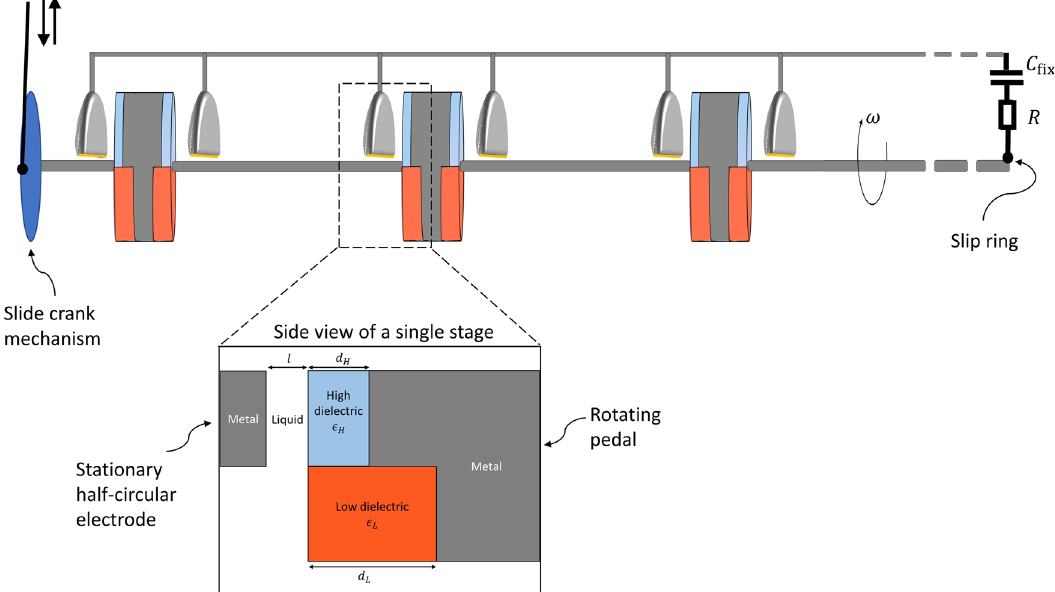
Fig. 2 Illustration of the energy harvesting device. The device comprises of a multi-stage rotor structure, connected to a reservoir capacitor C fix and to an electric load R . The design of the rotor structure is presented (not to scale) with an additional side view of a single stage which consists of a rotating disc and a stationary half-circular metal electrode; in the gap between the two is a lubricating liquid. Each rotating disc is shared by two adjacent stages, connected in a back-to-back fashion, in order to save space, reduce the overall mass and prevent electric shortcuts. All the stages are mounted on a common metal axle, thereby effectively connecting all stages in parallel. To ensure the prevention of shortcuts between the metal axle and the bottom of the half-circular electrode, the bottom should be insulated, as depicted by a thin yellow line. The rotor can be spun by different means, in the fi gure we show one option of a slide-crank mechanism, however it can equally be rotated by a wind- or water-turbine. Mechanical components to optimize the shaft rotational velocity (gearset, freewheel, and fl ywheel) have been omitted from the illustration for